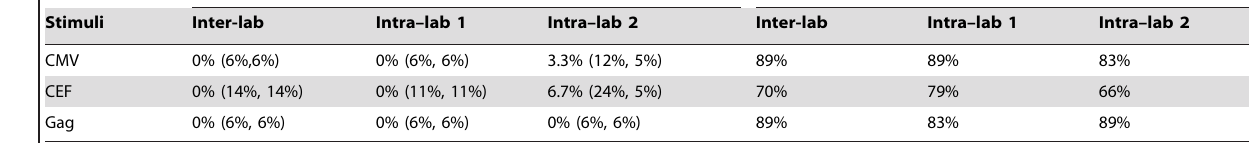
Observed differences in response rates (95%